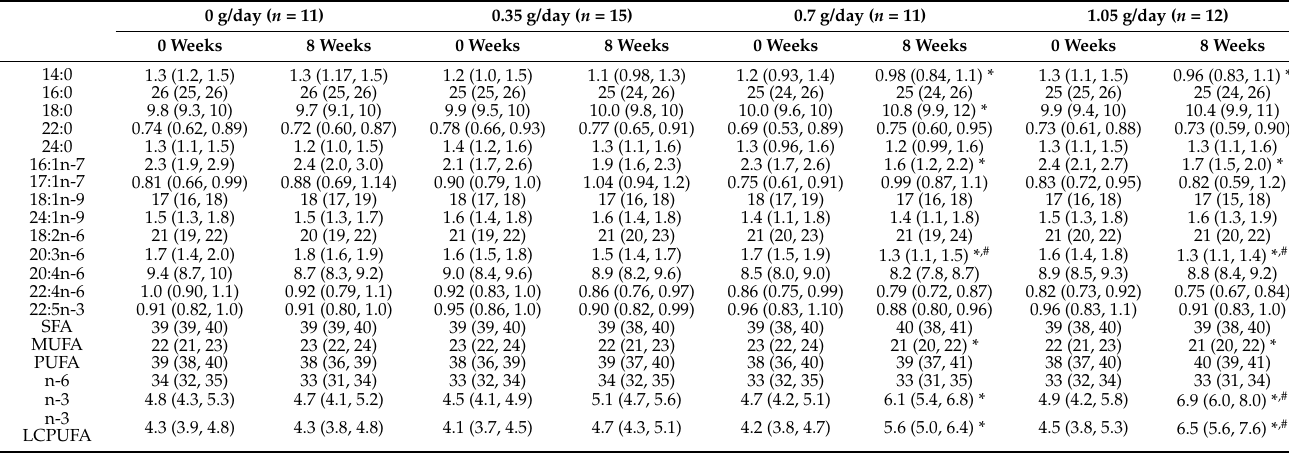
Values are mean (approximate 95% CI) calculated on the log scale and then back-transformed to raw scale for presentation ( n = 49). Differences between dose groups were compared using log-transformed data with ANCOVA followed by post hoc Tukey’s HSD tests. * Significantly different from placebo ( p < 0.05); # significantly different from 0.35 g/day ( p < 0.05). Fatty acids constituting < 0.5 mol % of total fatty acids not shown. For EPA and DHA values, refer to [26]. Abbreviations: SFA: saturated fatty acids; MUFA: monounsaturated fatty acids; PUFA: polyunsaturated fatty acids; n-3 LCPUFA: total n-3 long-chain PUFA is EPA, n-3 DPA plus DHA.